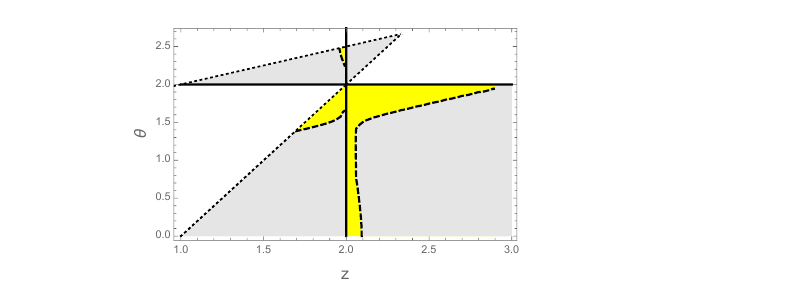
Figure 9 . Sign of the coe(cid:14)cient of H 2 of the transverse conductivity near H = 0. Yellow region denotes positive sign and gray region is for negative sign. Dotted line indicates validity regime. Here we use the parameters of (cid:12)gure 8 and T = 0 :